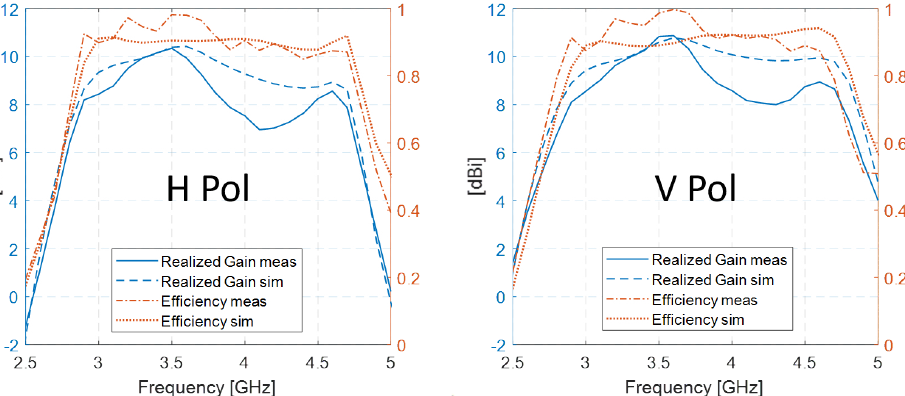
Figure 11. Scaled prototype: comparison between measurement and simulation in term of realized co-polar gain and total efficiency for both H/V